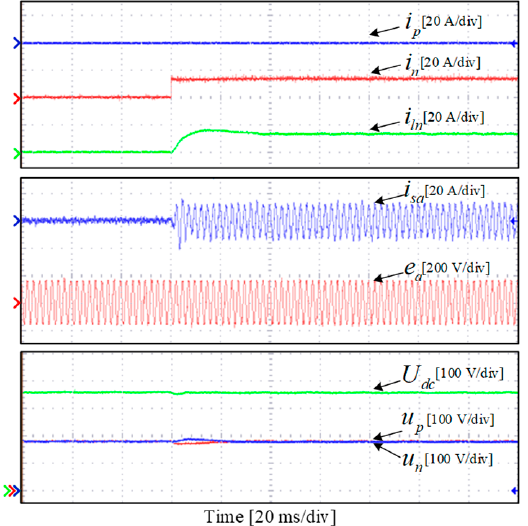
Figure 16. Load step experimental results under an unbalanced load